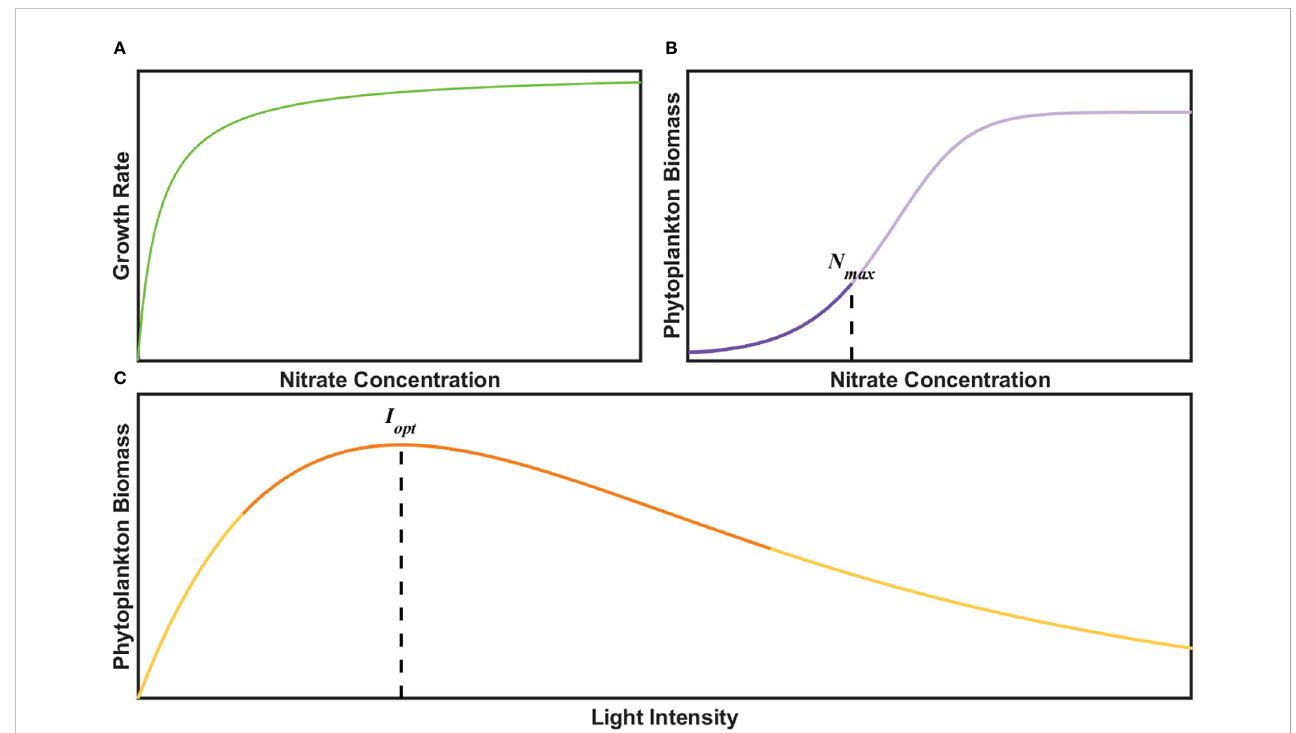
FIGURE 4 Schematic graph of (A) growth rate, (B) phytoplankton biomass as a function of N concentration according to Michaelis-Menten equation and (C) phytoplankton biomass as a function of light intensity with Steele equation. The bold lines represent multi-year averaged range of N and PAR in